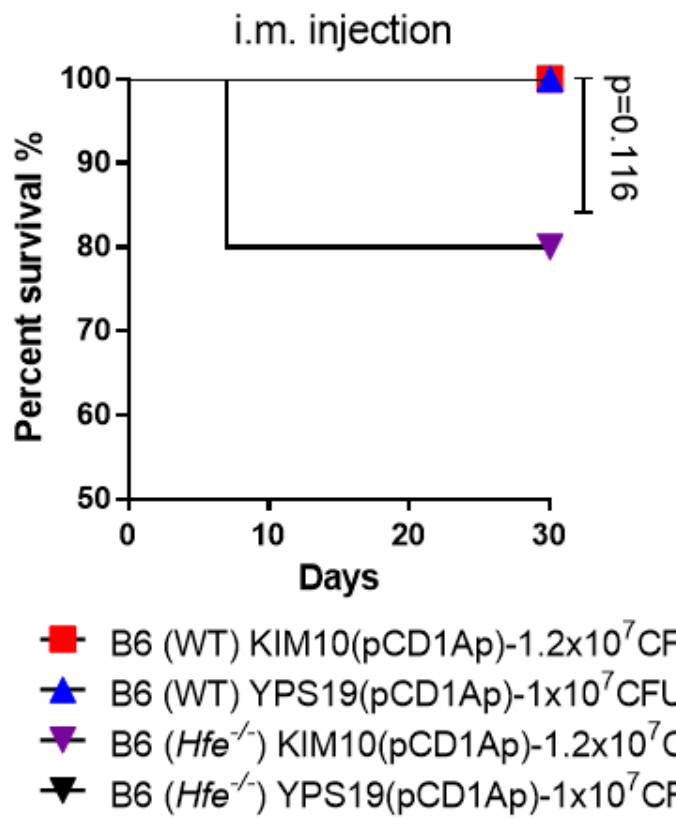
Figure 6. Safety assessment of live attenuated Y. pestis vaccine strains in wild-type and Hfe − / − C57BL / 6 mice. A single dose of 10 7 CFU of KIM10(pCD1Ap) and YPS19(pCD1Ap) were administrated i.m. to wild-type and Hfe − / − C57BL / 6 mice ( n = 10, 5 males and 5 females), respectively. These mice were observed for signs of mortality and morbidity for 30 days. The log-rank (Mantel–Cox) test was used for statistical analysis, the p value is